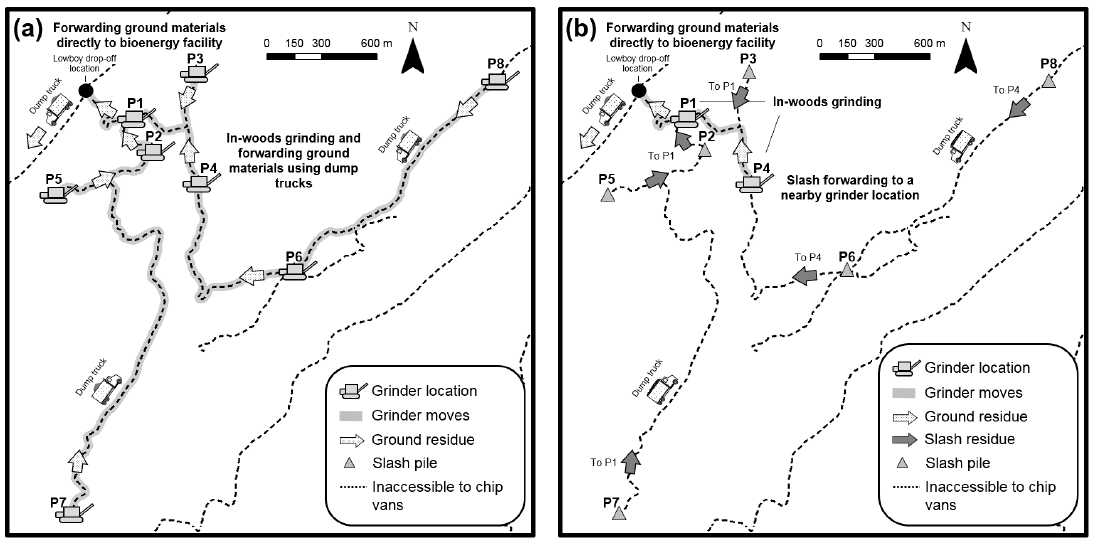
Figure 6. Conventional ( a ) and optimized ( b ) feedstock logistics presenting biomass flow and selected on-site grinding locations.